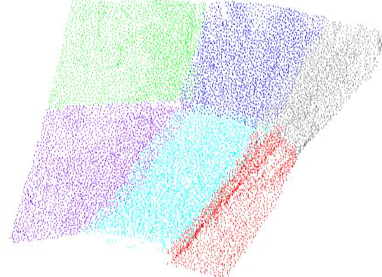
Figure 6: Mapping of TLS points to raster cells of the TRS